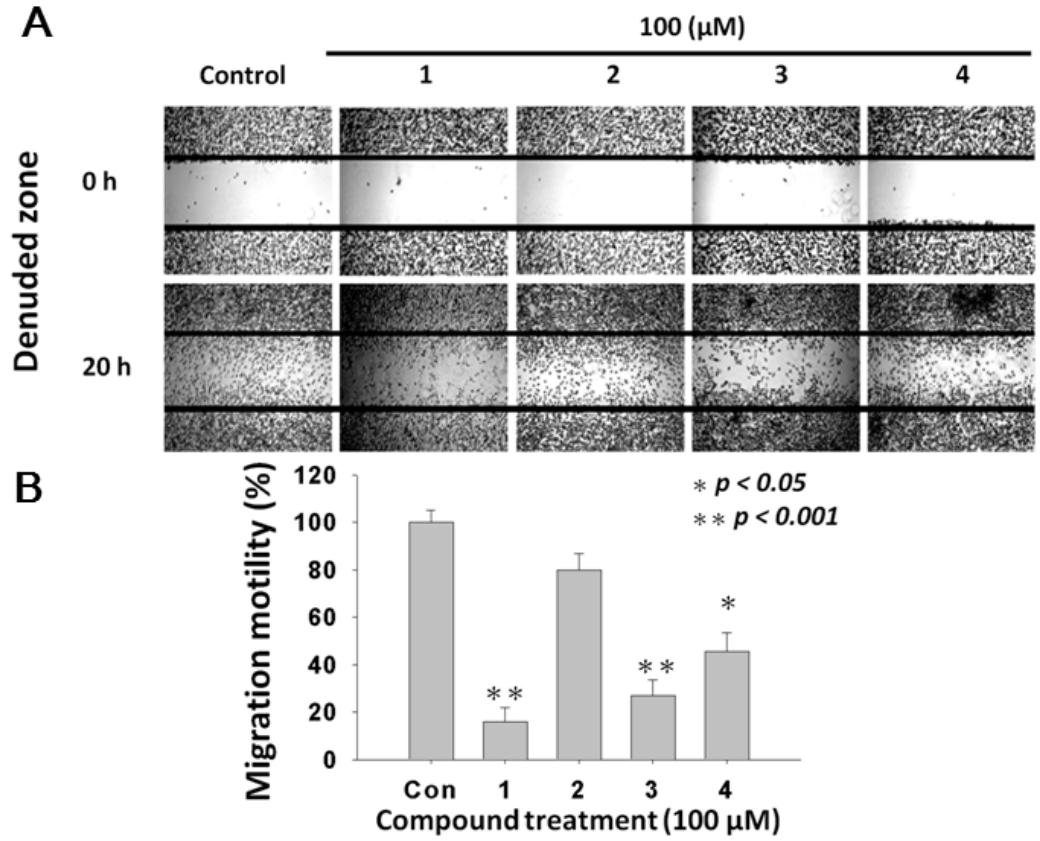
Figure 4. Effects of L. tulipifera compounds on migration of melanoma A375.S2 cells. ( A ) 5 × 10 5 cells were seeded onto a 12-well plate and cells were scraped to create a clean 1-mm wide wound area within the confluent culture. Cells were treated with 100 μ M of L. tulipifera compounds for 24 h. Afterwards, the wound gaps were photographed using an inverted phase-contrast microscopy. ( B ) The quantification analysis, * p < 0.01 for L. tulipifera compounds against vehicle, n =